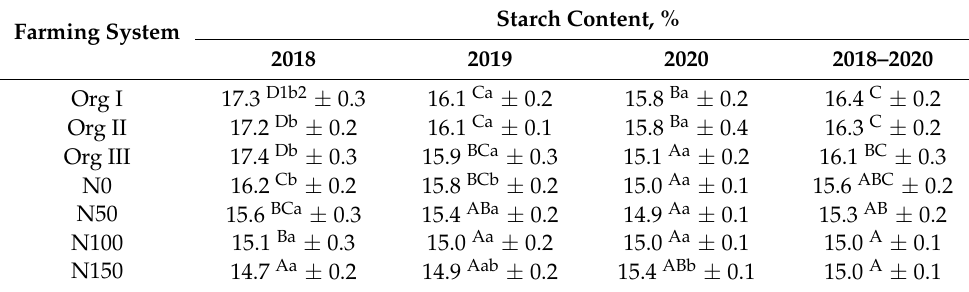
Table 8. Average starch content depending on the farming system. Farming